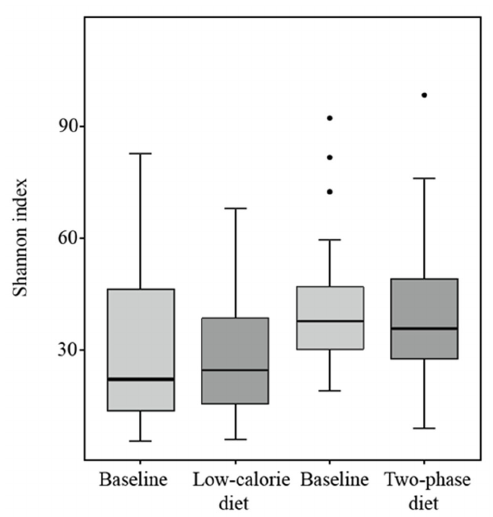
Figure 2. Alpha diversity evaluated by Shannon index at baseline and after the low-calorie and two-phase diets.